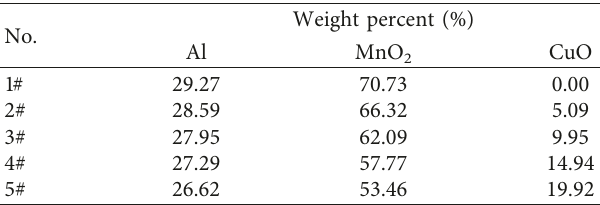
Table 1: Samples and corresponding formulations used for